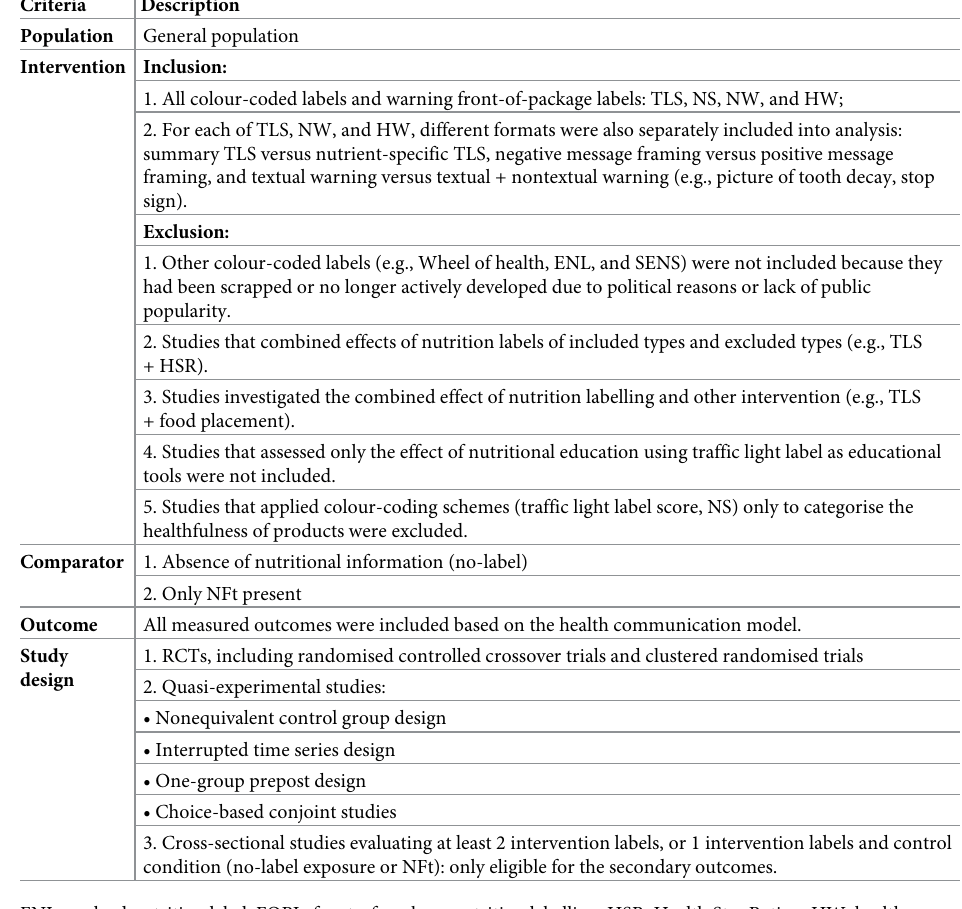
Table 1. PICOS criteria for inclusion and exclusion of